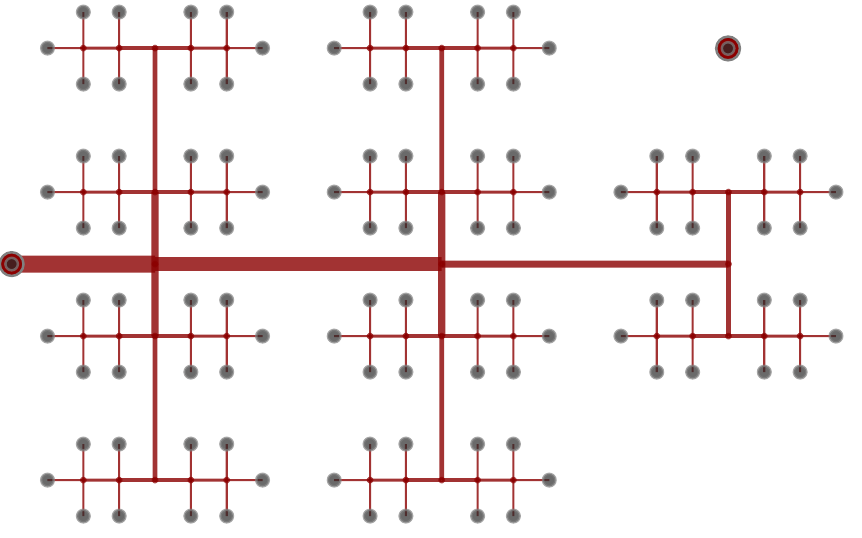
Figure 5. The spanning-tree network structure of the generic constructed district heating system: The various thicknesses of the edges symbolise the diameter of the installed pipes. Grey nodes represent the connected buildings and larger grey nodes with a red ring symbolise the heat